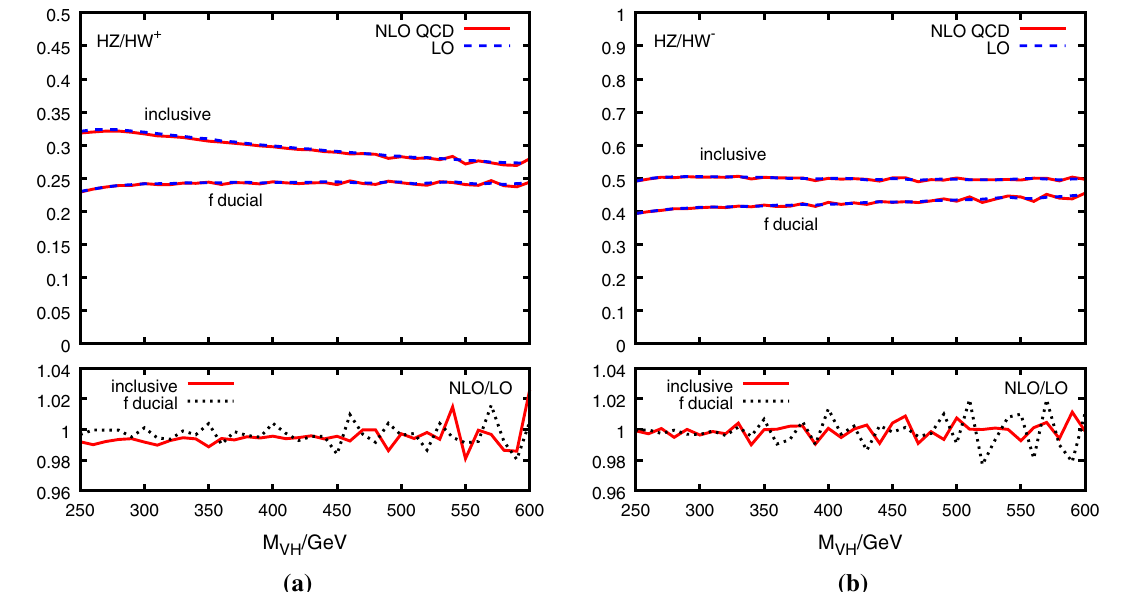
Fig. 4 QCD corrections (including qg → qVH ) to the ratio R ZW for a W = W + and b W = W − as a function of the VH invariant mass, V ∈ { Z , W } . The dashed/solid line in the upper parts of the plots show the LO/NLO QCD result, the lower parts show the ratio